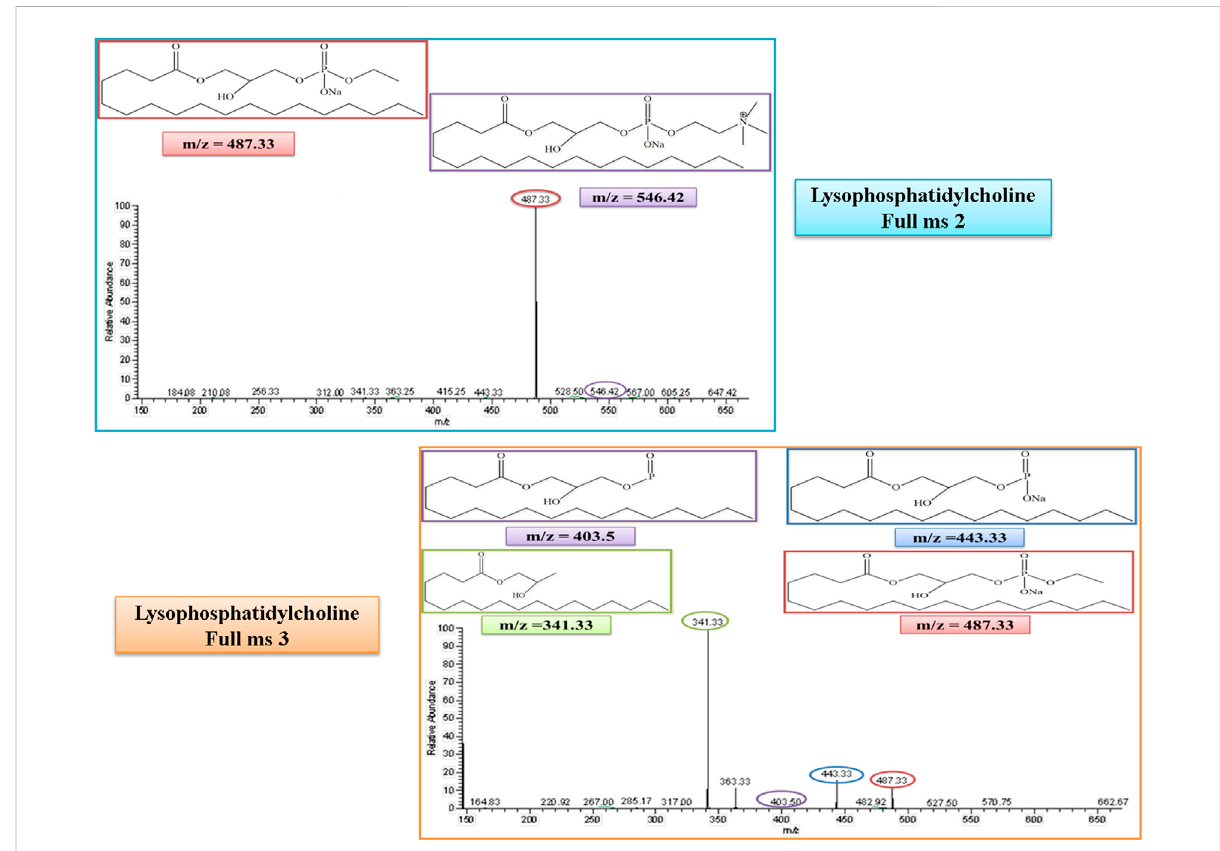
FIGURE 7 Full ms 2 and full ms 3 spectra of Lysophosphatidylcholine in positive ion mode. Each m/z peak is circled by a color similar to the color of the border of its